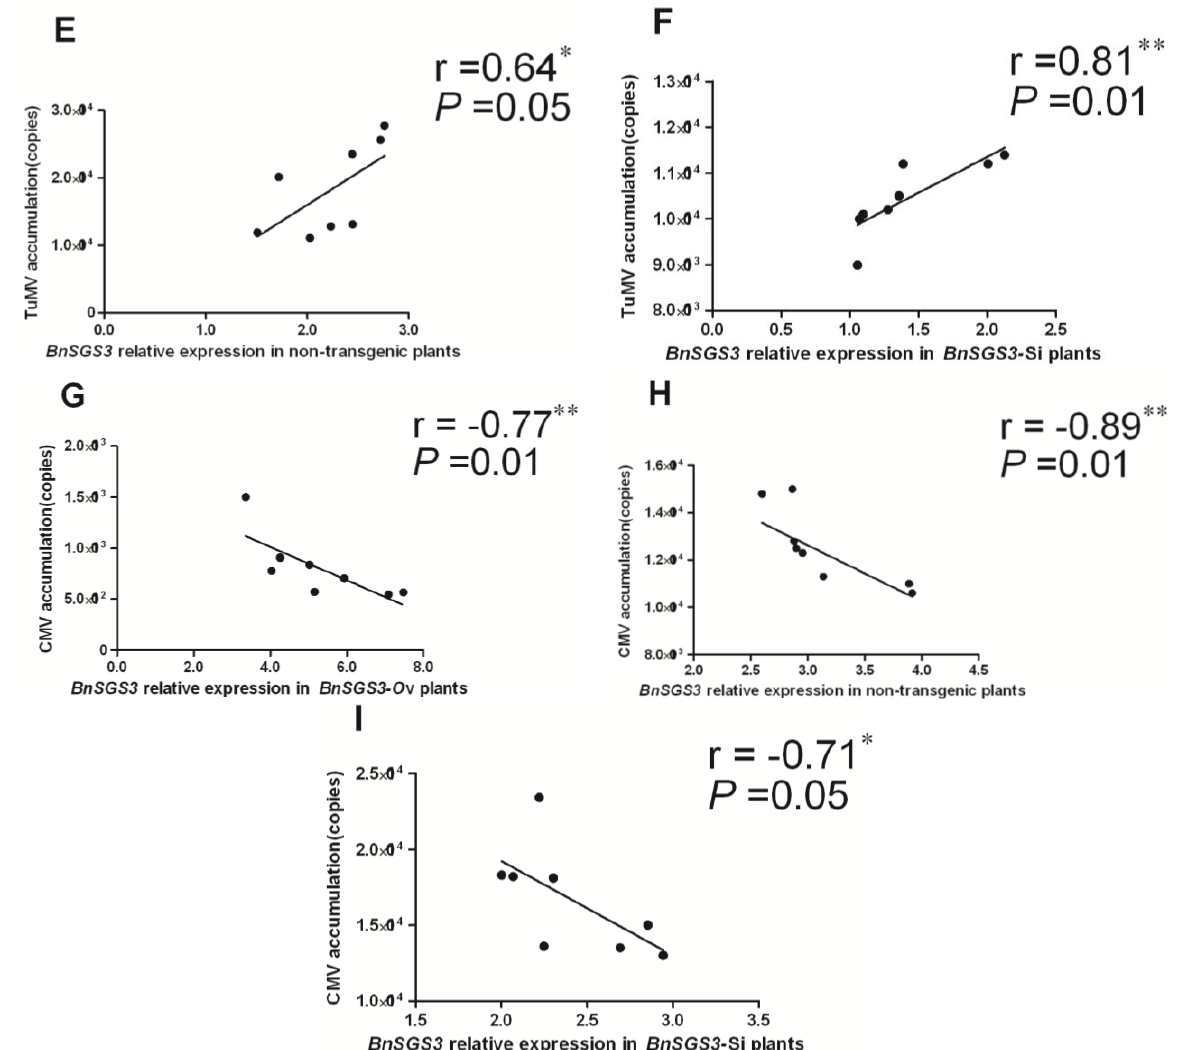
Figure 6. Relationship between the accumulation level of ORMV ( A – C ), TuMV ( D – F ) or CMV ( G – I ) and the expression quantity of BnSGS3 in BnSGS3 -Ov ( A , D , G ), non-transgenic ( B , E , H ) and BnSGS3- Si ( C , F , I )